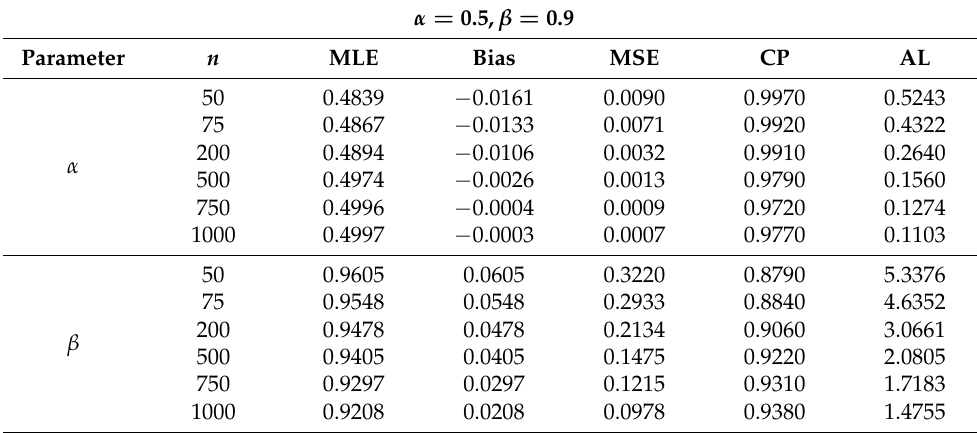
Table 3. Simulation results for α = 0.5 and β =